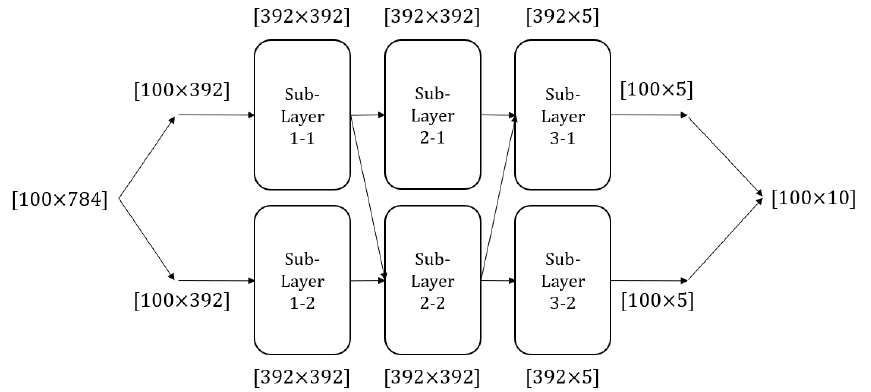
Figure 4. Dataflow in MLUTNet on MNIST. Algorithm 1 Training of